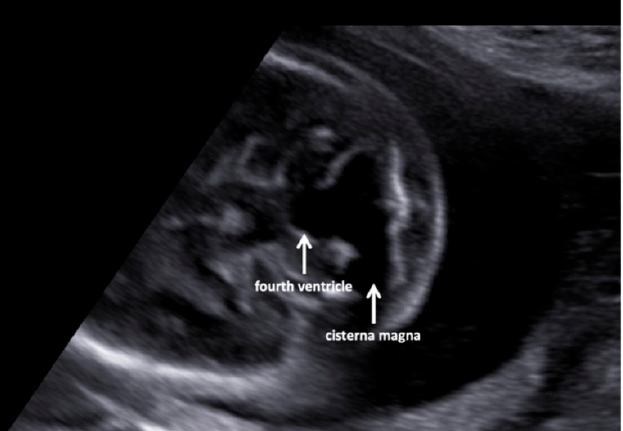
Figure 2. Axial views of the fetal head at the level of the mid-fourth ventricle (20 weeks of pregnancy), showing continuity of the fourth ventricle and cisterna magna. Table 1. Depth and coverage of the target